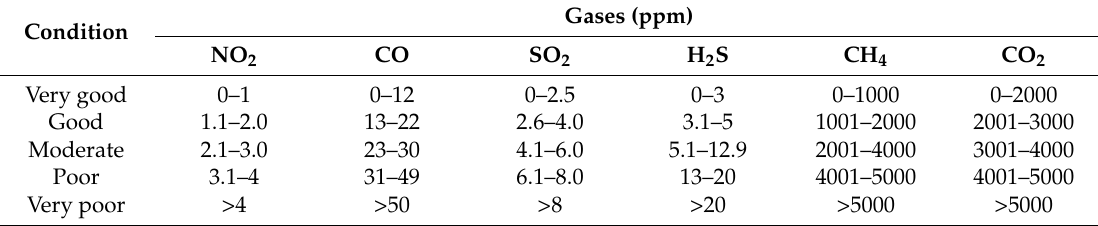
Table 2. Breakpoints of various gases for mine air quality index (MAQI) and its categories [41,42].